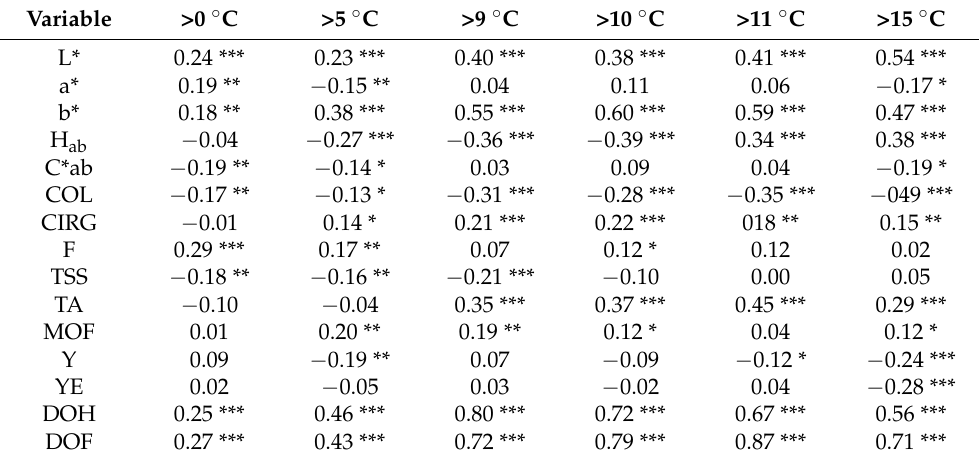
Table 15. Influence of the total of active temperatures until the harvest date on selected characteristics.